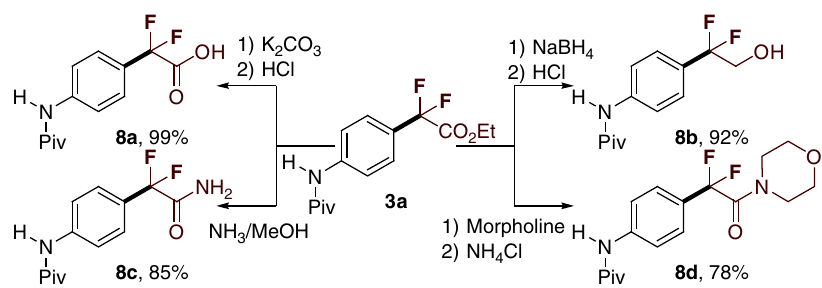
Fig. 4 Transformations of 3a . All the reactions were performed in 0.2 mmol scale. Isolated yields. a K 2 CO 3 , MeOH, 60 °C. b NaBH 4 , EtOH, r.t. c NH 3 , MeOH, 60 °C. d Morpholine, 60 °C